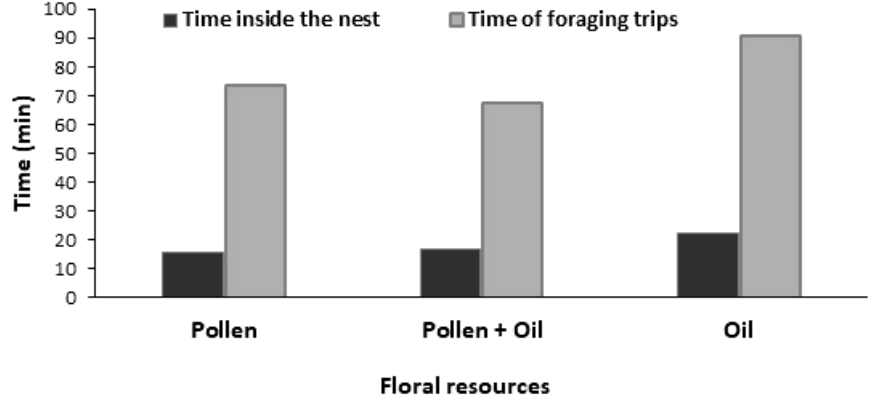
Fig 5. Average time spent by Epicharis dejeanii females inside the nest, after each foraging trip, and on foraging trips for collecting floral resources (only pollen, pollen + oil and only